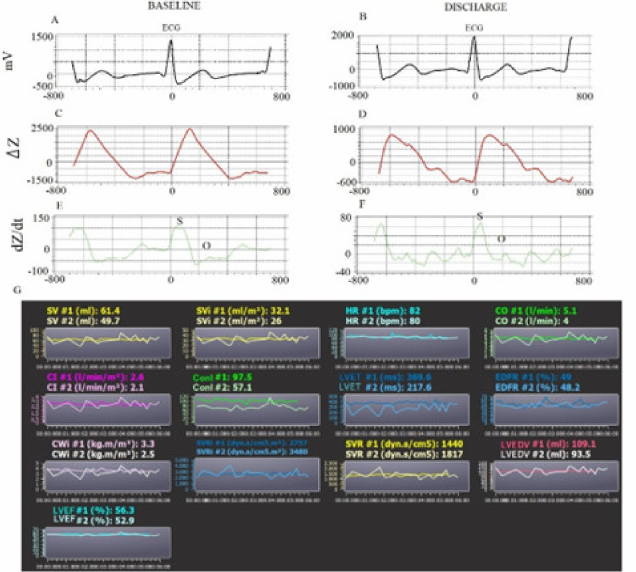
Figure 2. Example of 5 min noninvasive hemodynamic recordings at baseline and at discharge in HFpEF patients. ECG signals ( A , B ). Calibration Average Signals ( C , D ). Impedance Signals ( E , F ). Measured hemodynamic variables at baseline (#1) and at discharge (#2) ( G ). SV: stroke volume; SVI: stroke volume index; HR: heart rate; CO: cardiac output; CI: cardiac index; ConI: contractility index; LVET: left ventricular ejection time; EDFR: early diastolic filling ratio; CWI: cardiac work index; SVRI: systemic vascular resistance index; SVR: systemic vascular resistance; LVEDV: left ventricular end diastolic volume; LVEF: left ventricular ejection